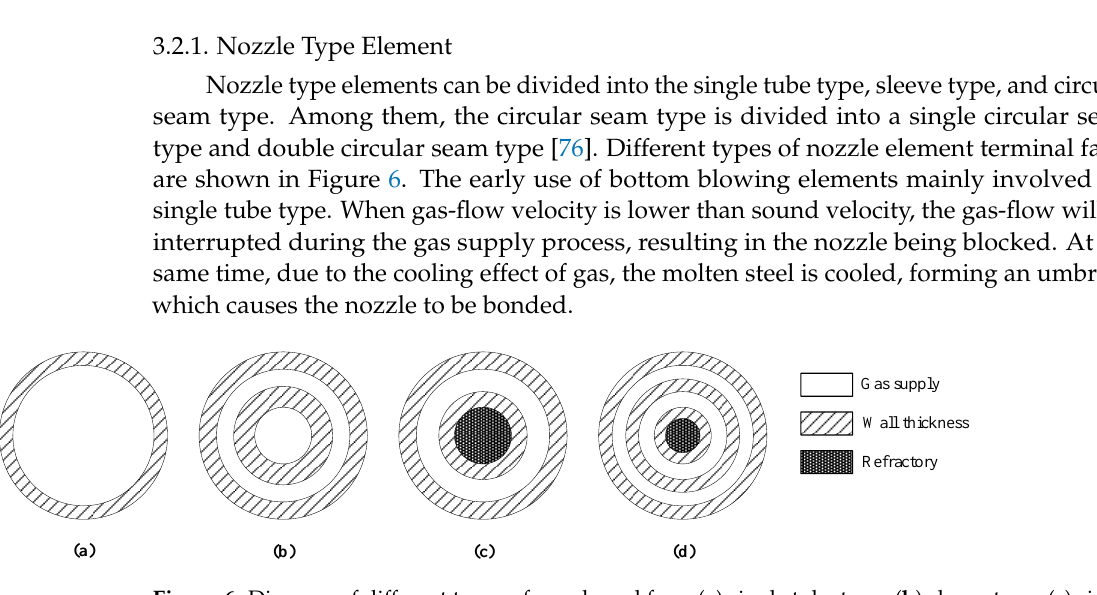
Figure 6. Diagram of different types of nozzle end face: ( a ) single tube type, ( b ) sleeve type, ( c ) single circular seam type, and ( d ) double circular seam type.